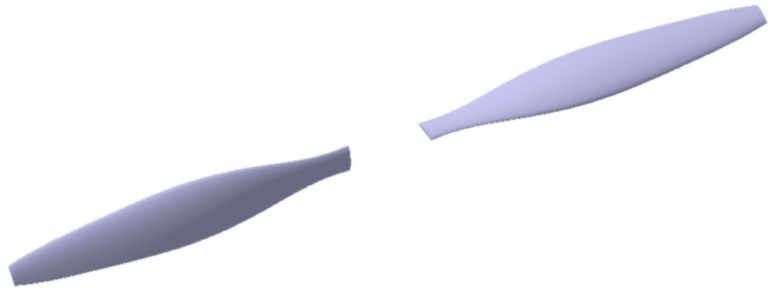
Figure 13. Solid model of the propeller.